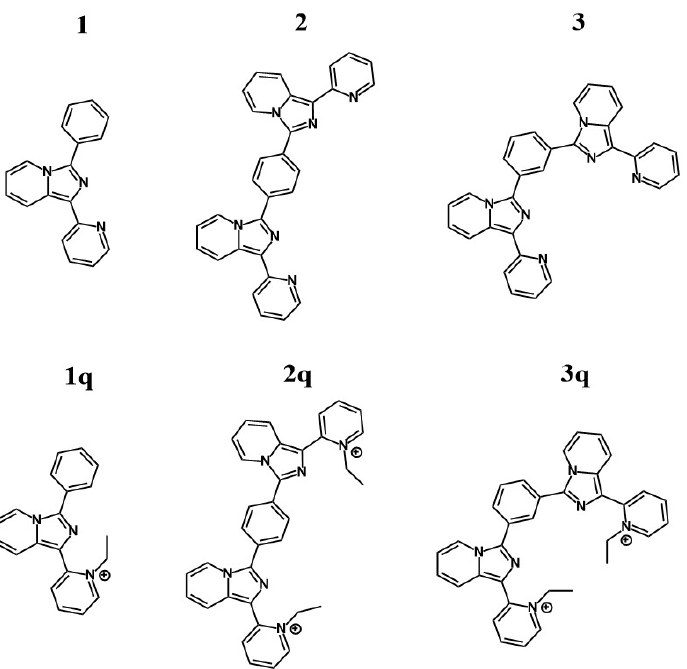
Figure 1. Structures of the molecules reported in this contribution.